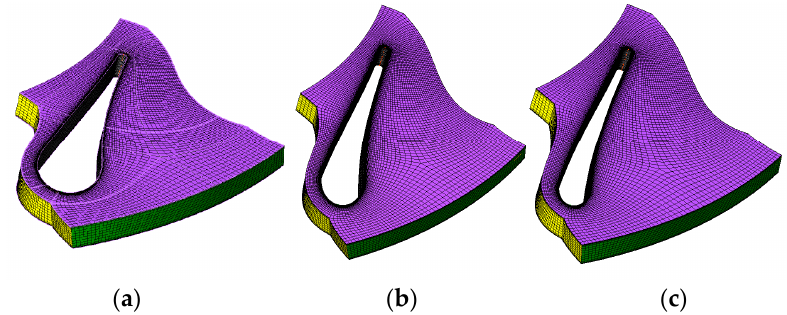
Figure 6. Mesh of three types of nozzle: ( a ) LED = 10 mm; ( b ) LED = 7 mm; ( c ) LED = 4 mm.